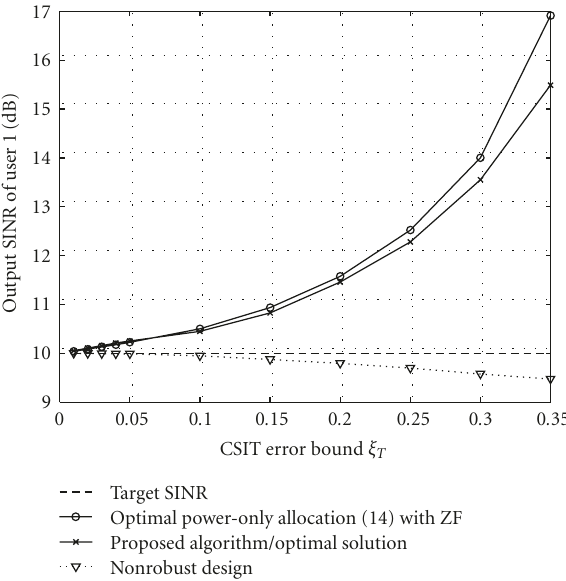
Figure 4: The user’s output SINR averaged over channel uncer- tainty for a given channel realization for various channel error bound for a 3-user (3,1) system with γ = 10